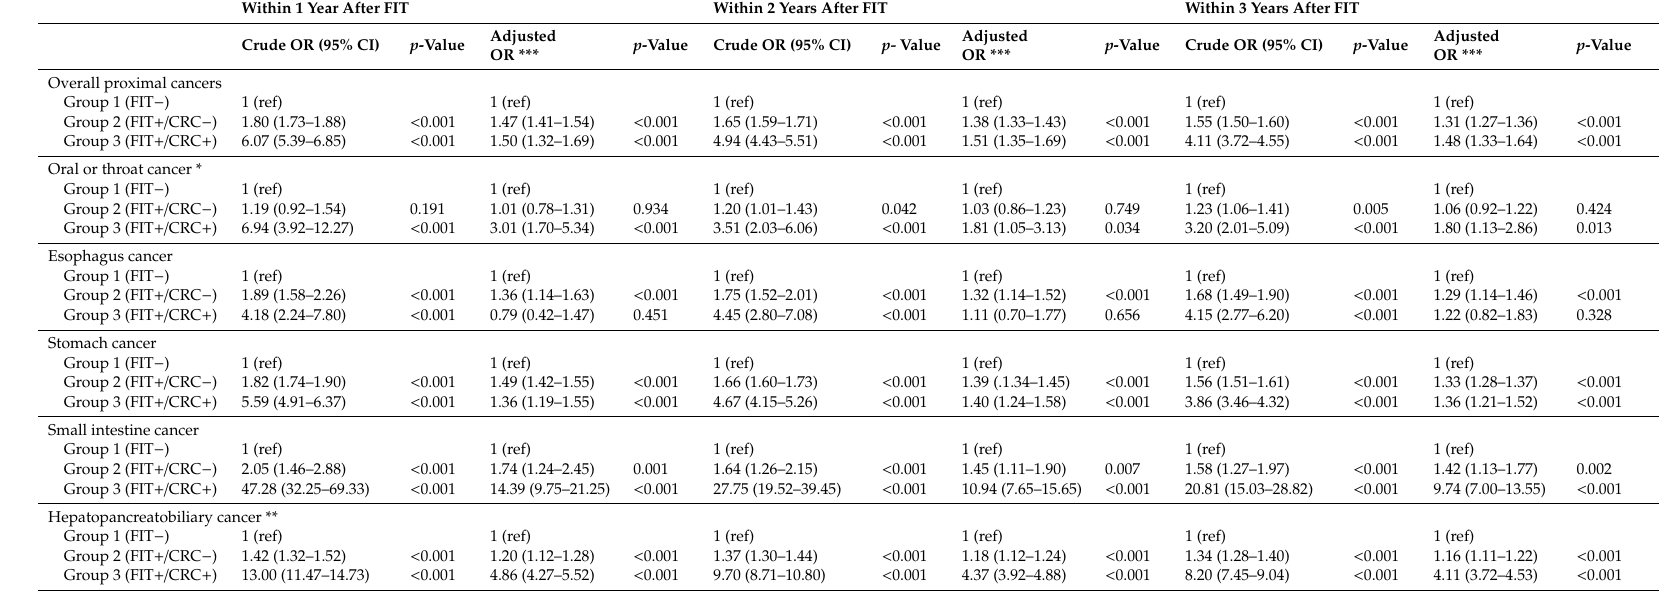
Table 3. Risks of proximal cancers according to FIT results and the presence of